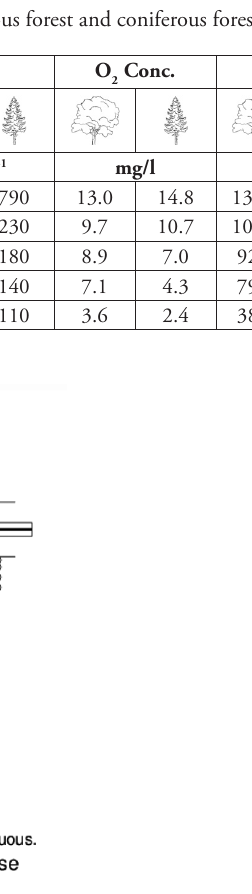
Figure 3. pH of springs of coniferous (left boxplot) and deciduous (right boxplot) forest land cover.